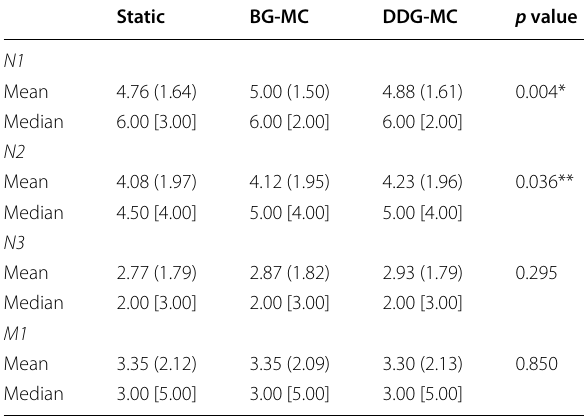
Table 3 Mean and median score s for N1, N2 and N3 and different